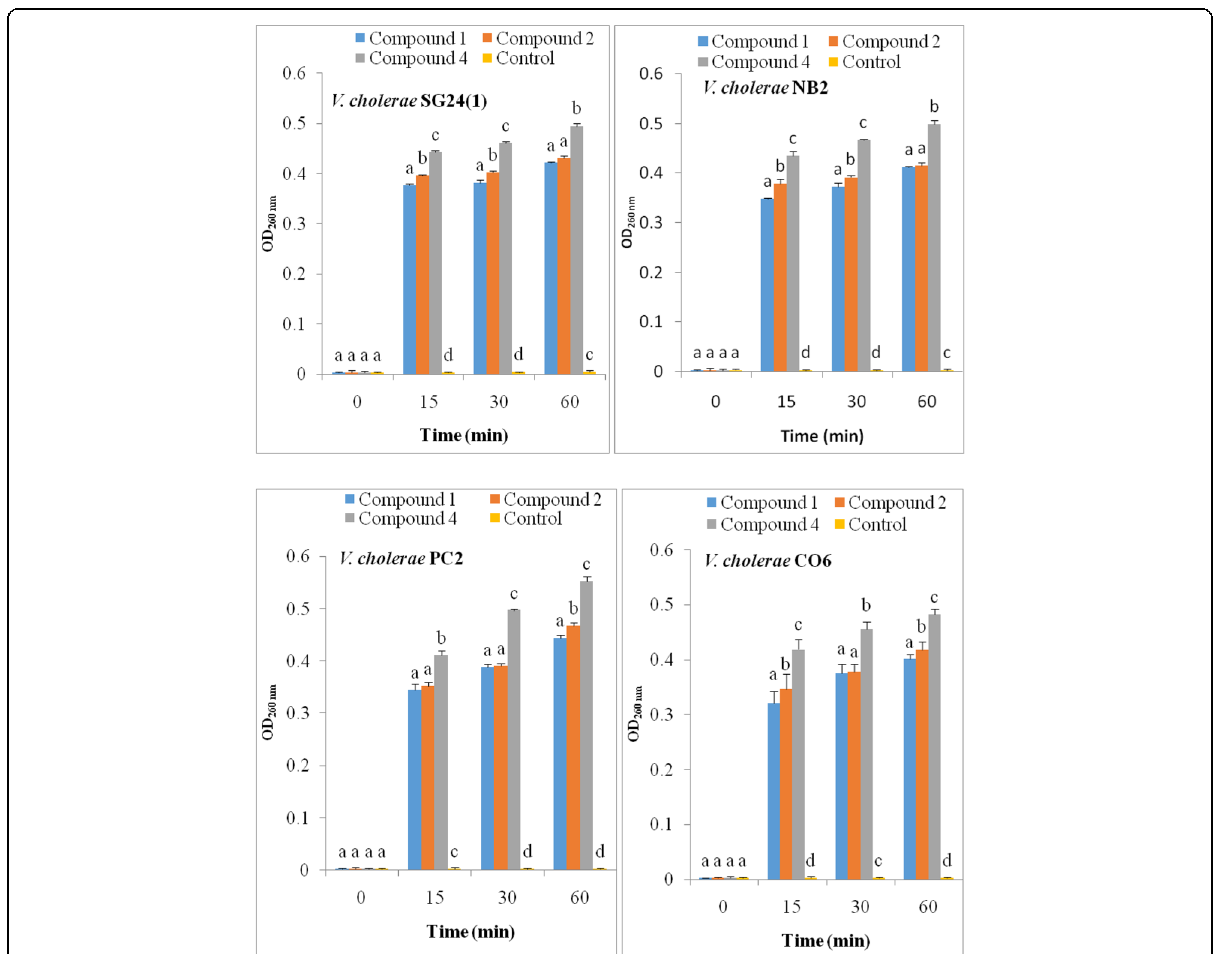
Fig. 2 Appearance of 260-nm-absorbing material in the filtrates of V. cholerae SG24 (1), PC2, NB2 and CO6 after treatment with compounds 1, 2 and 4 . Bars represent the mean ± standard deviation of the triplicate OD at each incubation time. At the same incubation time, letters a-d indicate significant differences between samples according to one way ANOVA and Waller Duncan test; p <